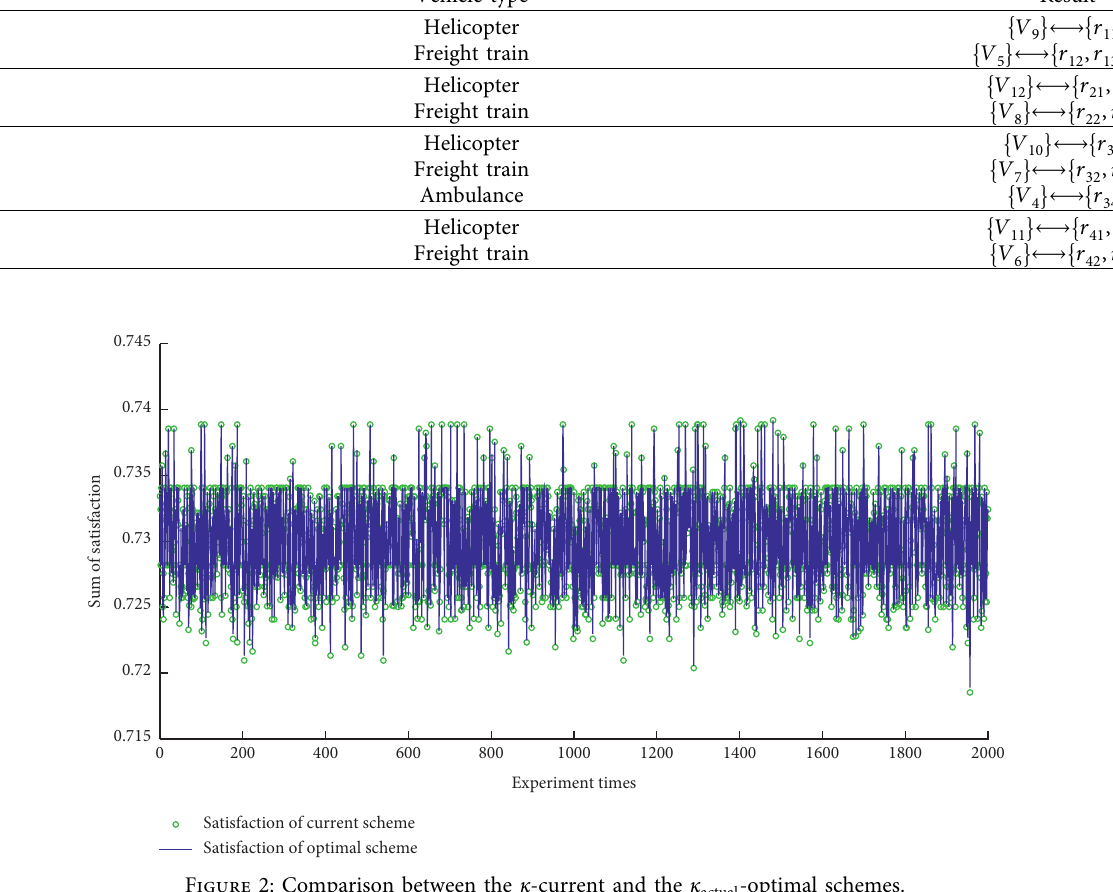
-optimal schemes. actual